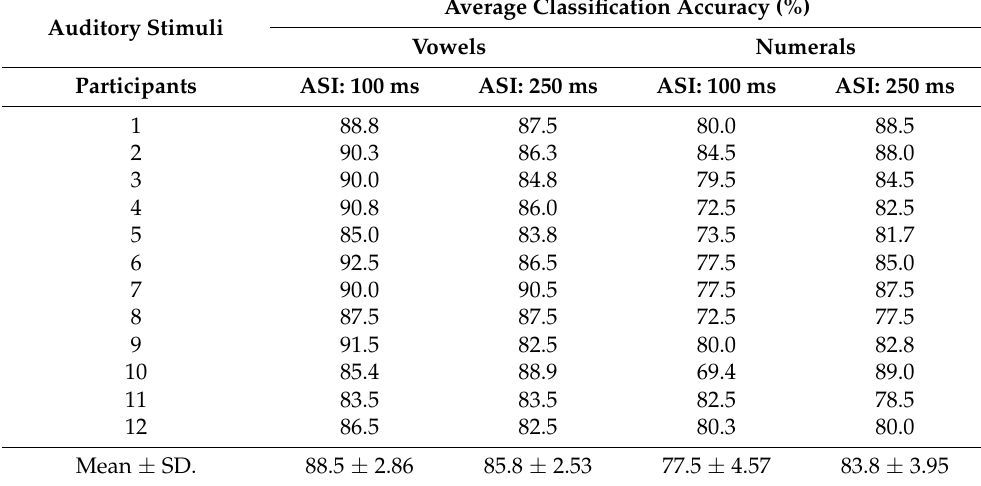
Table 5. Results of the average classification accuracy of different stimuli intervals (tone duration) of vowels and numerals for each participant.